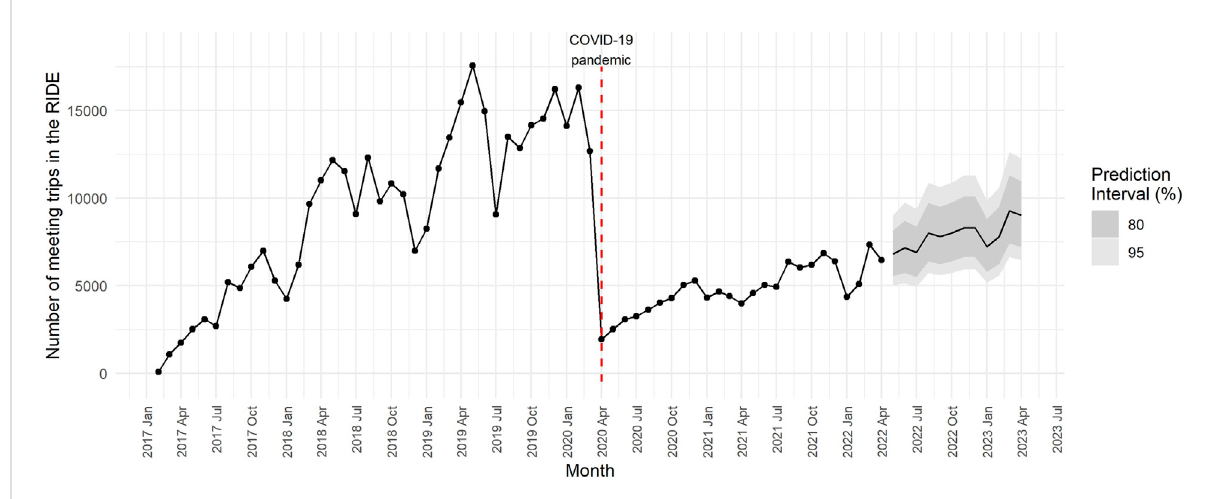
FIGURE 9 Forecast of the number of meeting trips for the following year (March 2022 to February